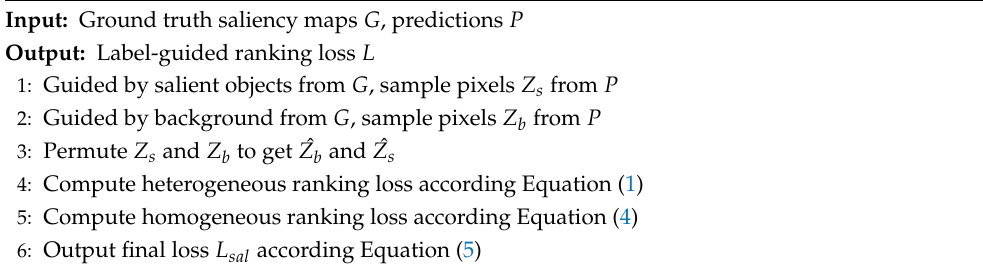
Algorithm 1 The procedure for label-guided ranking